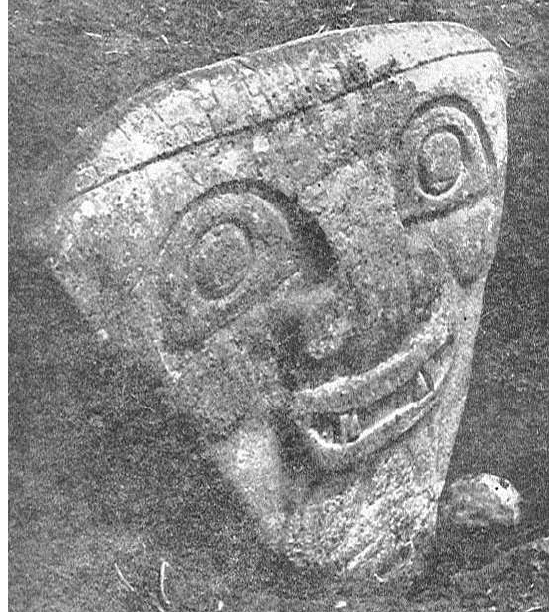
Figure 1. “Escultura 23”. Photograph from 1943. (Pérez de Barradas, 1943, table 72).